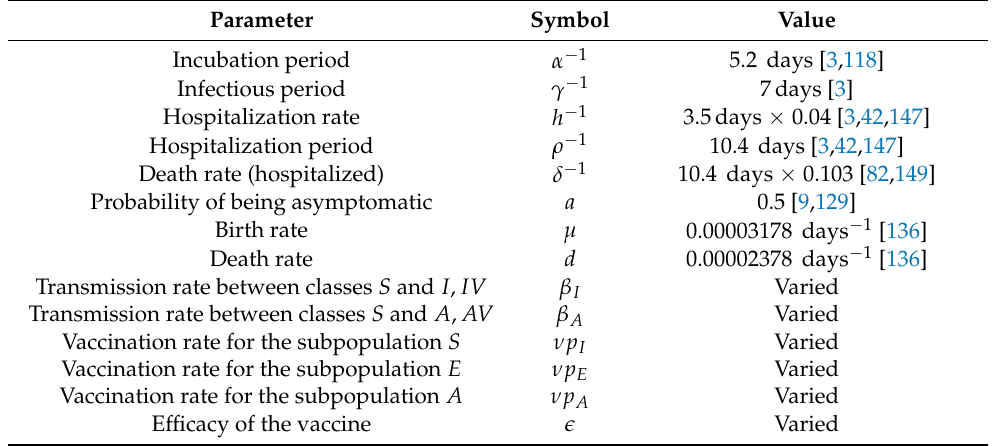
Table 2. Mean values of parameters used to perform numerical simulations of the different scenarios.